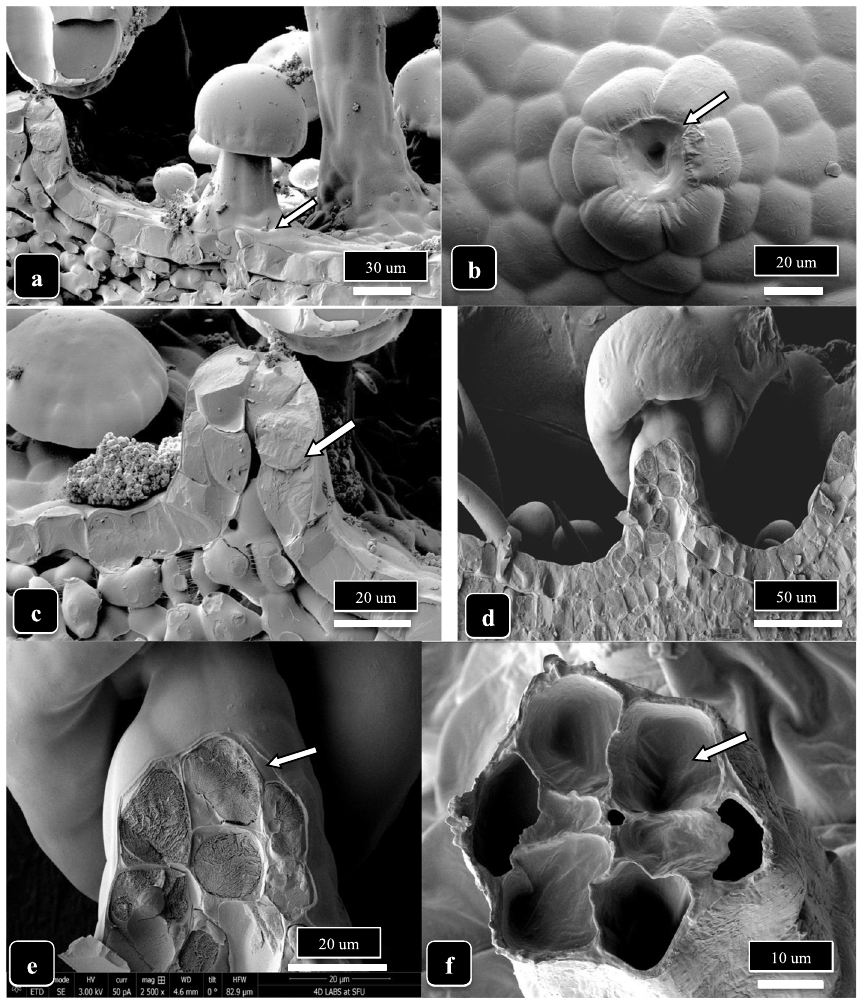
Fig. 7 Trichome stalk elongation in capitate trichomes of cannabis genotype MD. a Early development of a stalk arising from extension of the epidermal cells of the bract tissue (arrow). b A ring of six raised epidermal cells demarks the early initiation of the stalk. c The elongation of the stalk occurs by expansion and upward growth (arrow) of the epidermal cell layer as seen in this longitudinal section through a stalk. d , e Longitudinal sectional view of a fully formed stalk on a capitate trichome showing the involvement of epidermal and hypodermal cells to form the stalk. f Cross-sectional view of a stalk showing the organization of the six cells. The interior of the cells can be seen